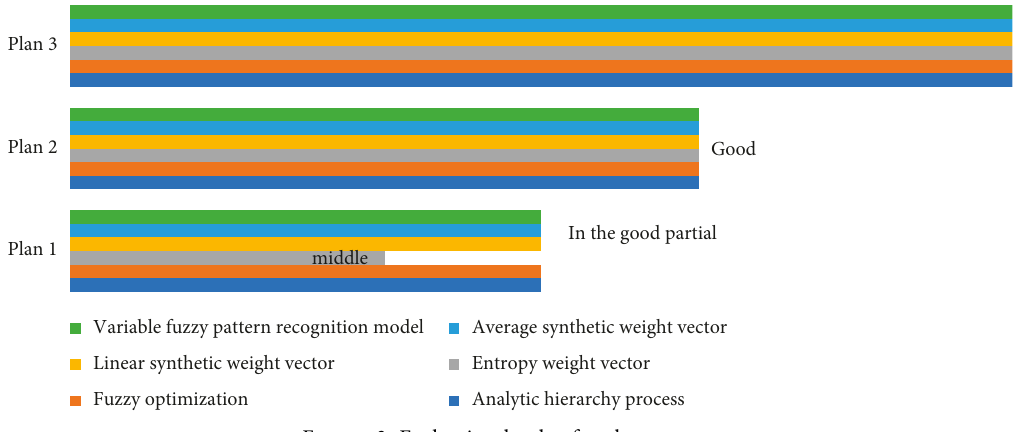
Figure 3: Evaluation levels of each